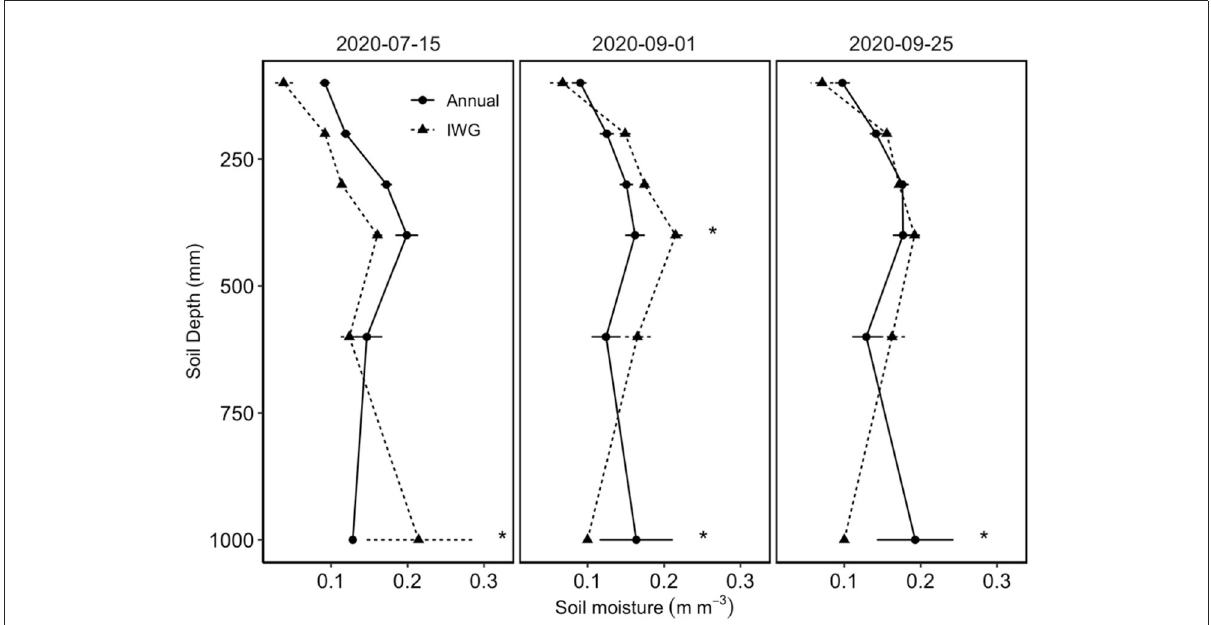
FIGURE2 Soil water content beneath soybean (annual) and intermediate wheatgrass (IWG) on days when there was a significant interaction between cropping system treatment and depth. Asterisks indicate depths for which soil water content differed significantly between cropping systems.